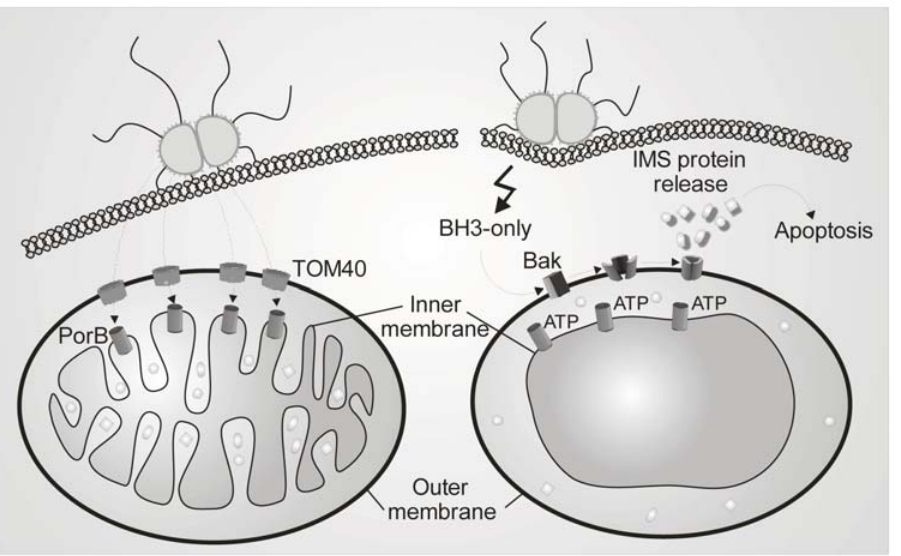
Figure 8. Model of PorB’s role in infection induced apoptosis. PorB integrates into the inner membrane and causes an ATP-dependent loss of DY m . Cristae remodeling by PorB sensitizes mitochondria for the BH3-protein induced opening of the OMM by Bak.